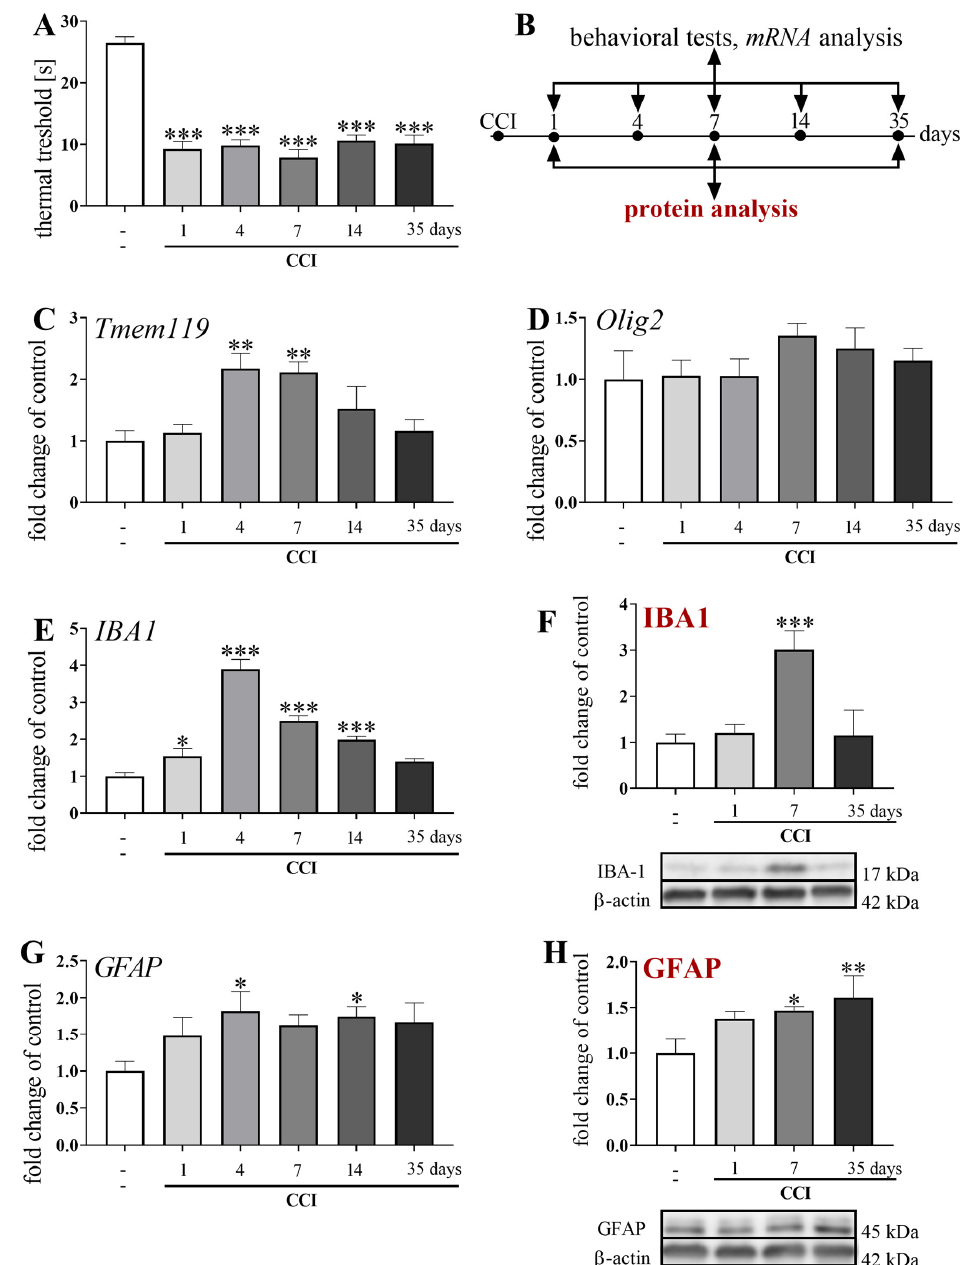
Figure 1 Figure 1. Development of thermal hypersensitivity in CCI-exposed mice (from 1 to 35 days) as measured via the cold plate test ( B ). Timeline of tissue collection at the indicated time points for behavioral and biochemical analyses ( D ). Time-dependent changes in the mRNA levels of Olig2 ( A ), TMEM119 ( C ), IBA1 ( E ), and GFAP ( G ) measured via RT-qPCR, and in the protein levels of IBA1 ( F ) and GFAP ( H ) measured via Western blot in the spinal cord of naive and CCI-exposed mice (from 1 to 35 days). The data (n = 5–10) are presented as the mean fold changes relative to the control ± SEM for the biochemical assays and the mean ± SEM for the behavioral tests. The results were evaluated using one-way ANOVA followed by Bonferroni’s post hoc test for comparisons of selected pairs. * p < 0.05; ** p < 0.01; and *** p < 0.001 indicate significant differences vs. the naive group. Abbreviations: -: naive; CCI: chronic constriction injury of the sciatic